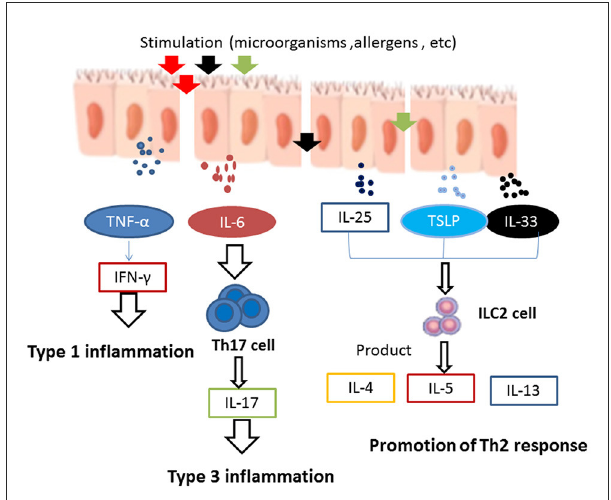
FIGURE1 When exposed to foreign irritants, nasal epithelial cells secrete a wide variety of inflammatory cytokines, such as TNF- α , TSLP, IL-25, IL-33, and IL-6. TNF- α can promote the release of IFN- γ . It is generally believed that CRSsNP mainly involves Th1-type inflammation and high expression of IFN- γ . Epithelial-derived cytokines, such as TSLP, IL-25, and IL-33, promote the Th2 response in the development of innate lymphoid cells (ILCs) and induce the production of Th2 cytokines, such as IL-4, IL-5, and IL-13, which can further enhance type 2 inflammation. IL-6 induces the differentiation of naive T-cells into Th17 cells and produces the type 3 cytokine IL-17, which is involved in type 3